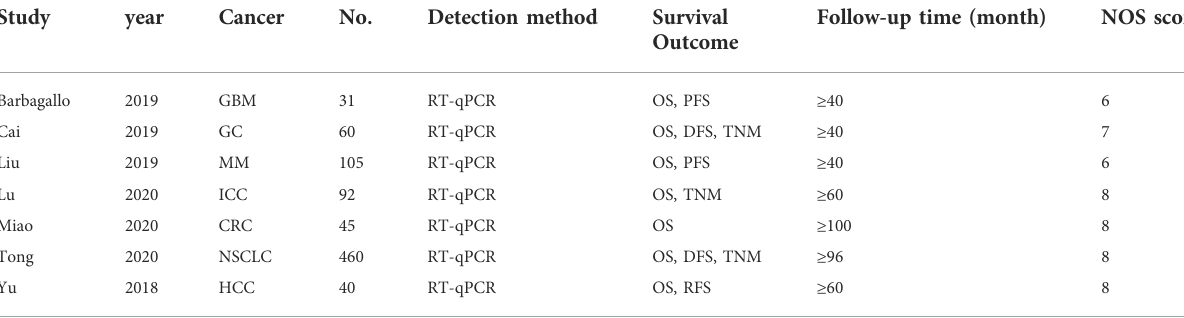
TABLE 3 Characteristics of the studies included in the present meta-analysis.